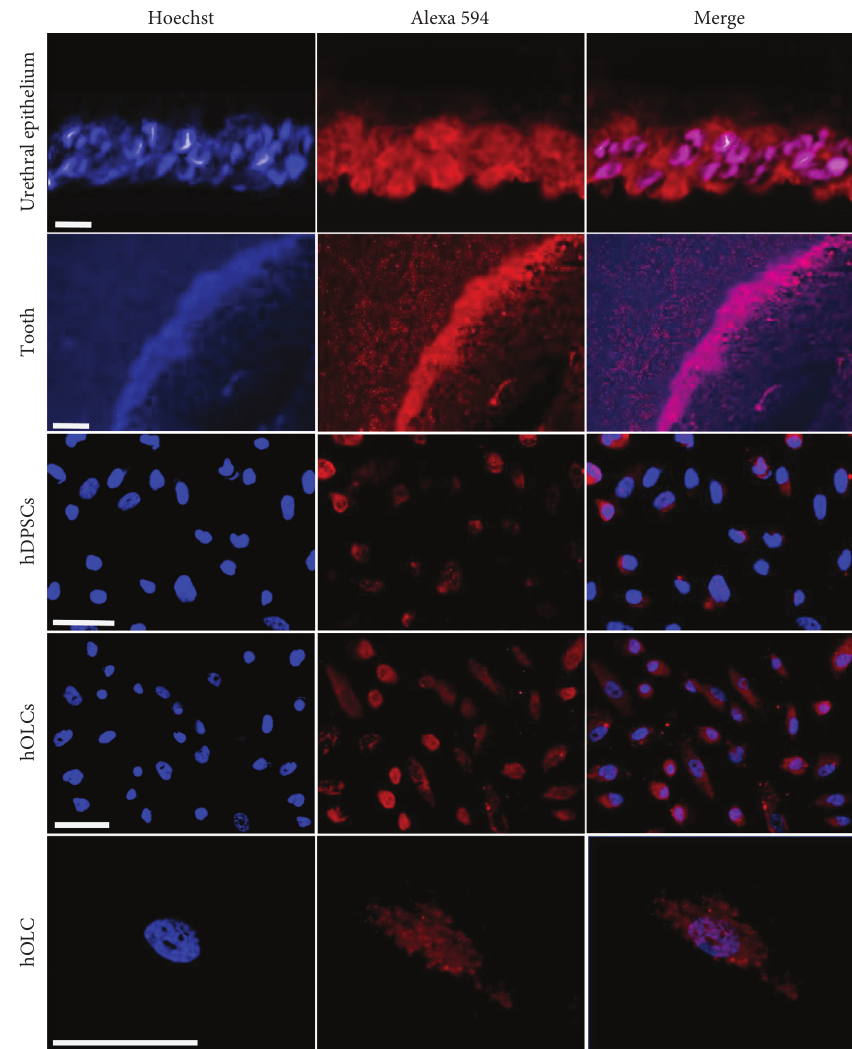
Figure 4: Immunocytochemical detection of TRPV1 receptor in hOLCs. Immunocytochemical identification of TRPV1 in the control of urethral epithelial tissue, in dental tissue, in hDPSCs cells, and in hOLCs. Anti-TRPV1 antibody conjugated with Alexa fluor 594 (red) was used to obtain the protein labeling and the nuclei were counterstained with Hoechst stain (blue). Note the positive staining in the dental tissue located in the area of the odontoblast palisade. Additionally, in hOLCs cells, an increase in this immunostaining localized in the membrane is evident, compared to hDPSCs. Zeiss Axio Imager A2 microscope was used. Scale bar: 50 µ